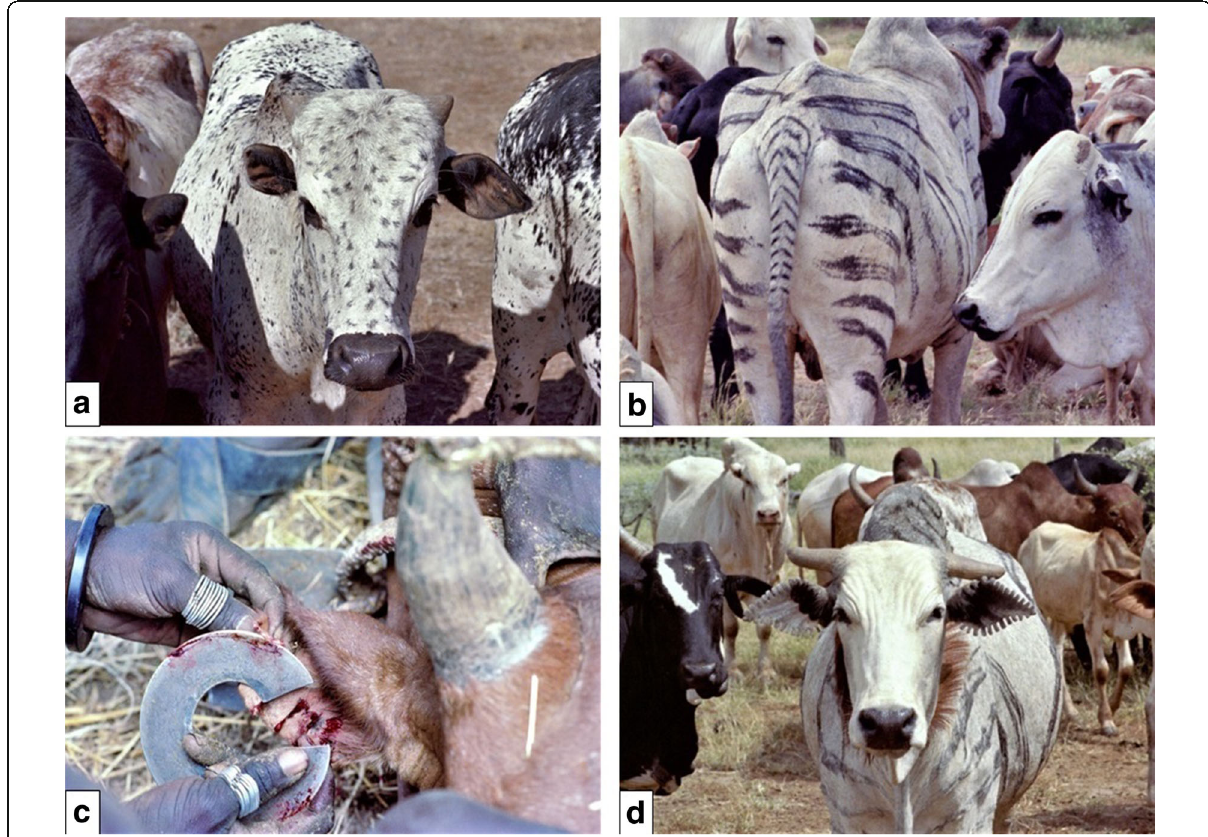
Fig. 7 a Detail of the head of a favourite-ox with numerous blackish spots obtained by “ spot branding ” , Oropoi. b Detail of the tail of a favourite-ox with numerous black lines, Oropoi. c Ear of favourite-ox being decorated, Lotikipi Plain. d Head of a favourite-ox showing ear pattern decoration,